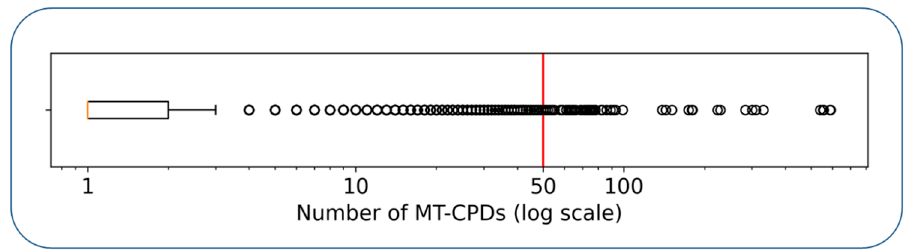
Figure 1. MT-CPDs for systematically explored kinase triplets. The boxplot shows the number of MT-CPDs (on a logarithmic scale) for all possible kinase triplets with at least one available MT-CPD. The left and right boundaries of the box indicate the upper and lower quartile of the distribution, while the vertical orange line represents the median value. The whisker shows the maximum of the distribution. Values exceeding the maximum are statistical outliers and depicted as circles.